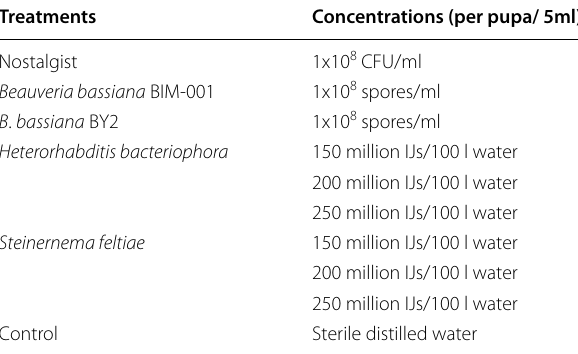
Table 1 Application doses and